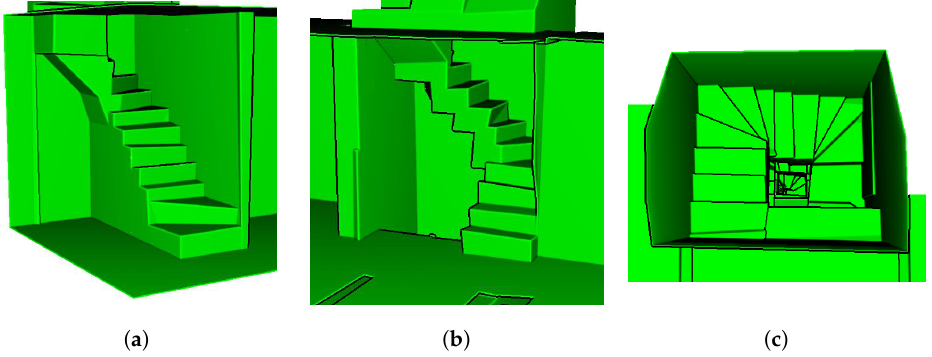
Figure 12. Detailed images of dataset C3. ( a ) inter-floor connection between underground and first floor, ( b ) inter-floor connection between first and second floor, and ( c ) top view of inter-floor connection between third and fourth floor.